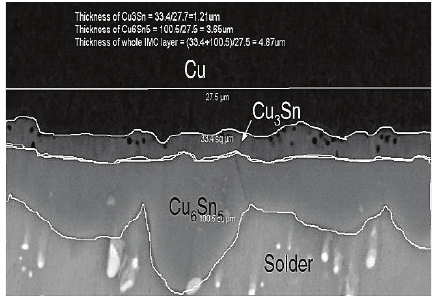
Figure 10: The sample was aged at 150 ∘ C for 100 h. Cu 6 Sn 5 had scal- lop-like shape and Cu 3 Sn is more of layer type